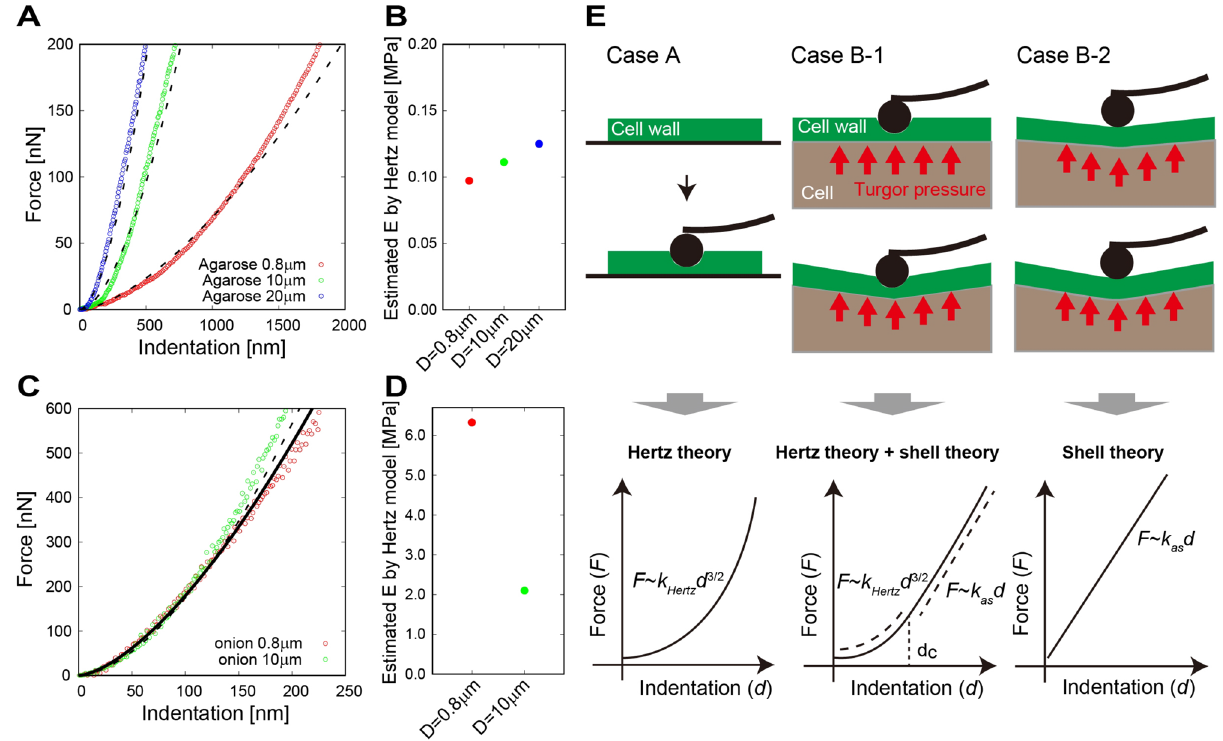
Figure 2. AFM measurement with different cantilever tip size for agarose gel and an onion epidermal cell. ( A ) Force–indentation curve with different tip sizes (0.8, 10, and 20 µm) for agarose gel. Dashed lines represent curves fitted using the Hertz model. ( B ) Estimated Young’s modulus from the Hertz model. ( C ) Force– indentation curve with different tip sizes (0.8 and 10 µm) for the onion epidermal cell. Solid line represents the curve for 0.8 µm, and dashed line represents the curve for 10 µm fitted using the Hertz model. ( D ) Estimated Young’s modulus from the Hertz model. ( E ) Previously reported interpretations of AFM measurement using a combination of Hertz contact theory 11–16 and elastic shell theory 9,22–27 . Case A: Fixed cell wall without turgor pressure. In this case, Hertz contact theory can be applied, with force-indentation fitting using F ~ k Hertz d 3/2 . Case B: Cell wall under turgor pressure. Scenario B-1 (cantilever indents and warps the cell wall): force-indentation can be fitted usin F ~ k Hertz d 3/2 if d < d c and F ~ k as d if d > d c , where d c can be smaller than the diameter of the cantilever (300 nm in ref. 9). Scenario B-2 (cantilever only warps the cell wall): force-indentation can be fitted using F ~ k as d